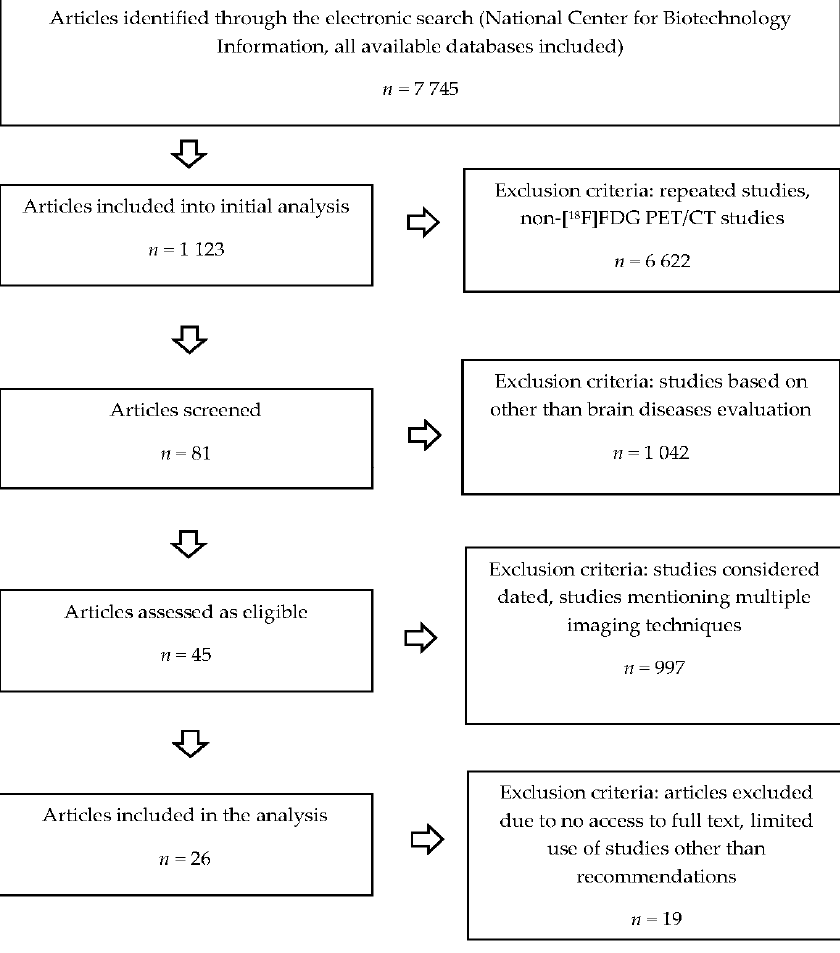
Figure 1. Flow diagram of literature search methods (source: original figure).